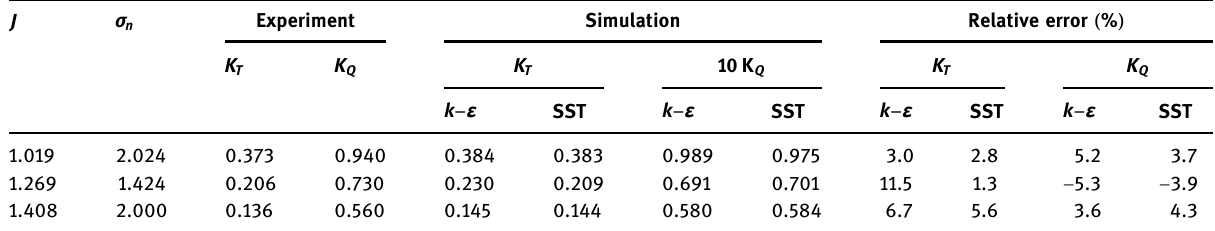
Table 5: Comparison results between experimental test and numerical simulation using the Zwart cavitation model J σ n Experiment Simulation